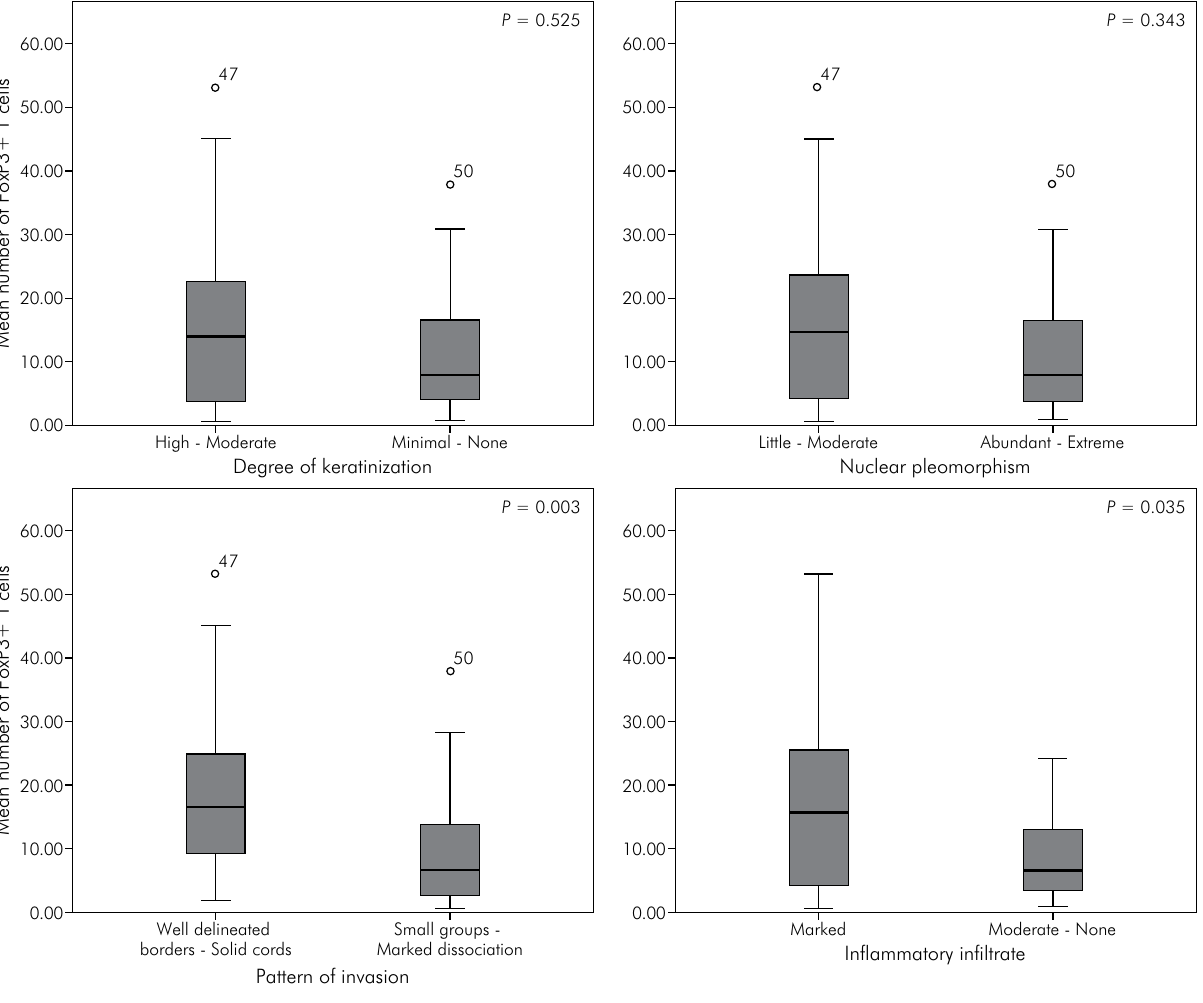
Figure 3. Box plot charts illustrating the number of FoxP3+ lymphocytes in LLSCCs according to degree of keratinization, nuclear pleomorphism, pattern of invasion, and inflammatory